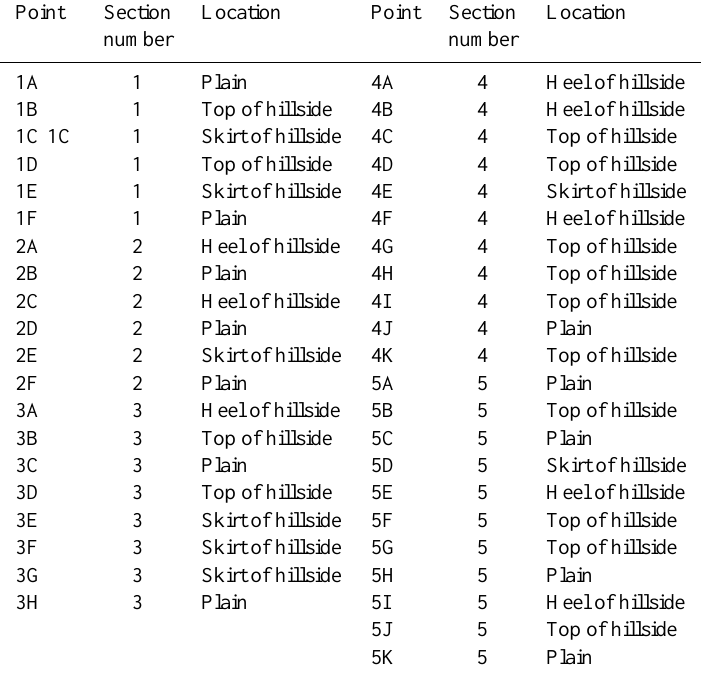
Table 1. Selected points and their locations.